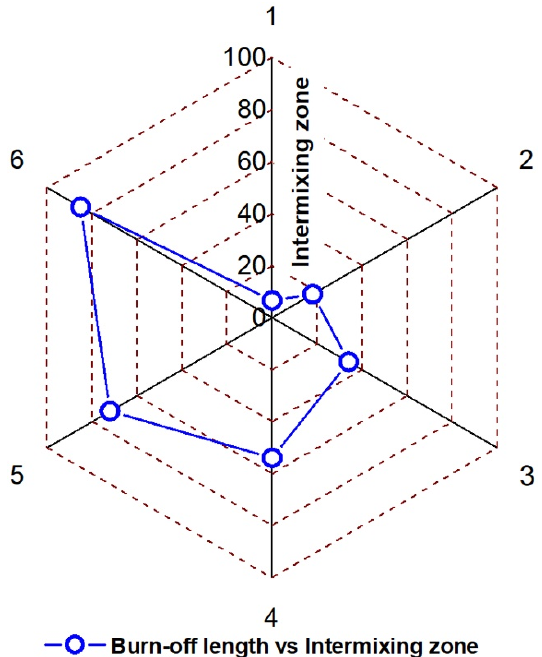
Figure 12. Intermixing zone variation according to burn-off length.